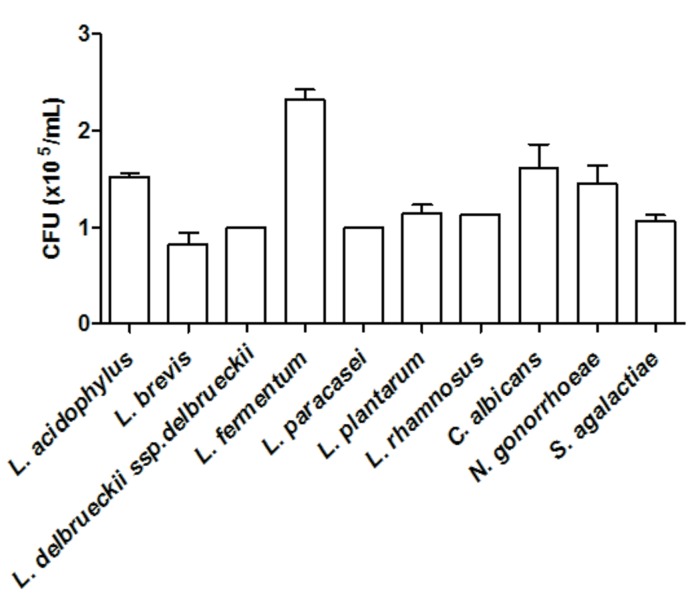
Quantification of mucin adhesion by Lactobacillus spp. (~4.5 × 107 CFU/ml) and genital pathogens (~1.5 × 108 CFU/ml). The values are expressed in CFU/ml and represent the means of the values obtained. The assay was performed in triplicate.